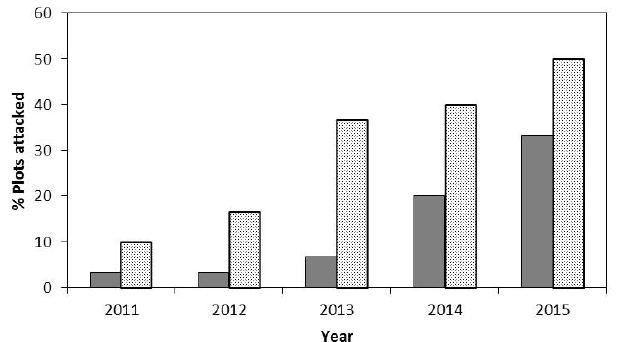
Fig 4 . Percentage proportion of concrete slab plots treated with chorpyrifos attacked by termites over 5